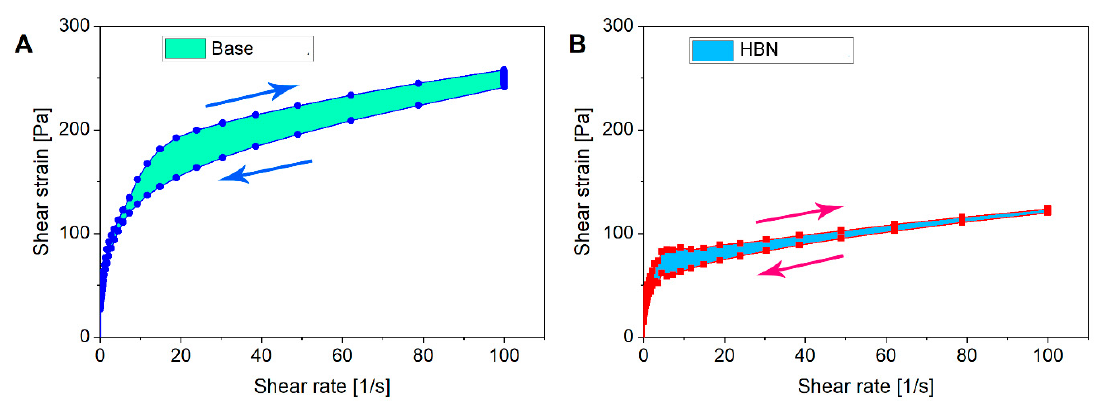
Figure 4. Flow curves of the control and the formulation at 25 °C to calculate the hysteresis area. Error bars were always lower than 10%. The error bars are omitted for clarity purposes. The experiments were repeated three times. ( A ) Base; ( B ) HBN.